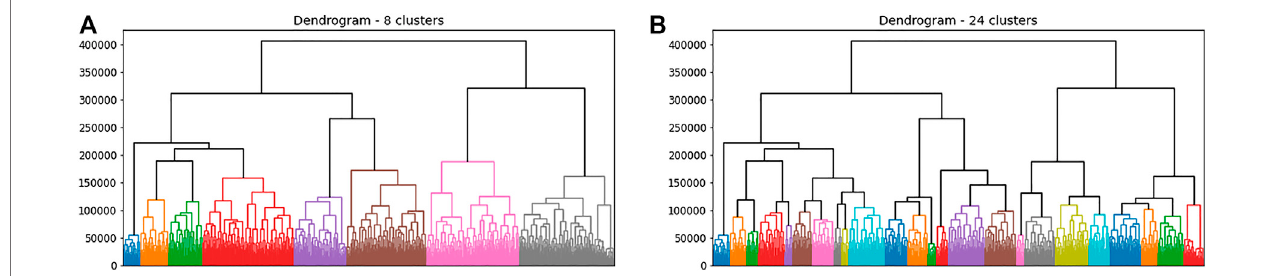
FIGURE4 | Hierarchical recognition of8 large and 24smaller modes discovered assubsets ofrelatively similar outputs from distinct dynamical experiments, using the dissimilarity matrix from Figure 3 . There were 1,024 forcing experiments in total, carried out on an N ≈ 10 6 node system, with ( K , M ) (cid:2) ( 1024 , 32 ) , and average in and out degree z (cid:2) Q / K ≈